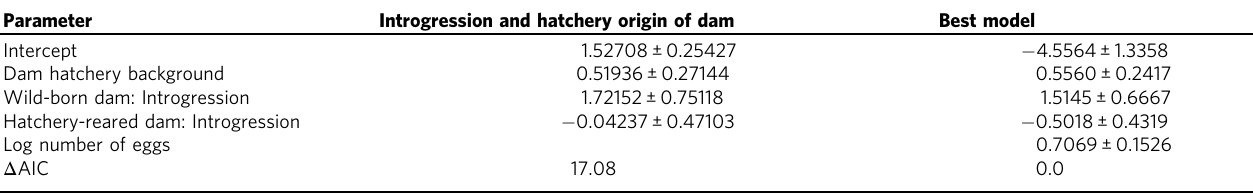
Table 1 Parameter estimates for least square regression models with log number of recaptured adult offspring as response Parameter